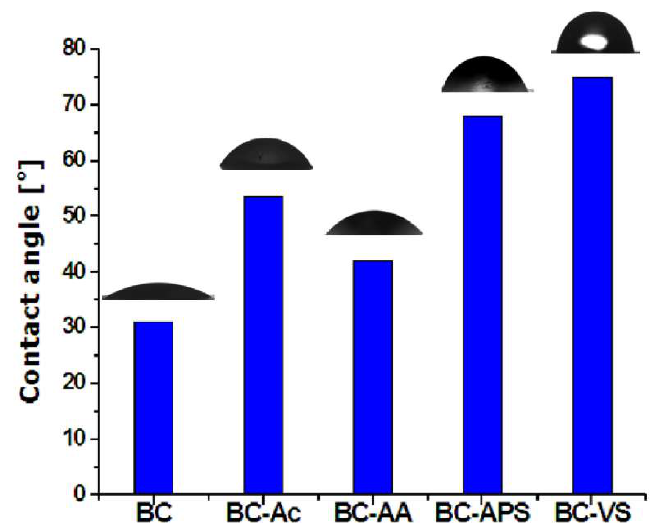
Figure 4. Contact angle values of untreated (BC) and treated membranes (BC-Ac, BC-AA, BC-APS and BC-VS); the images of the droplets for CA calculations were added for each type of membrane.